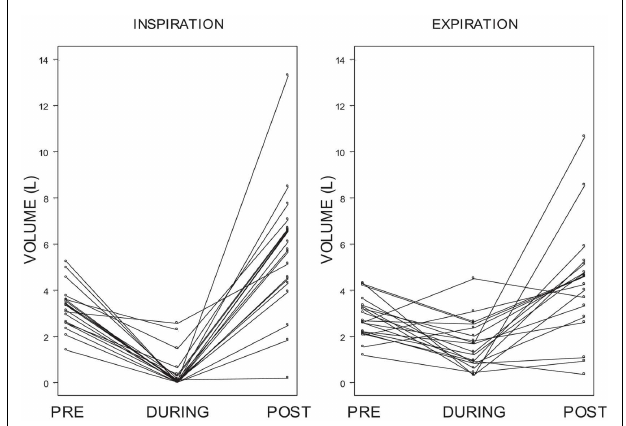
FIGURE 7 | Individual differences in inspiratory and expiratory volume. Shows individual inspiratory and expiratory volumes for each of the 5 -s periods of time measured: pre-ECD, during ECD, and post-ECD. For the vast majority of subjects there was a dramatic decrease in inspiratory volume from pre-ECD to during ECD exposure and a greater increase from during ECD to